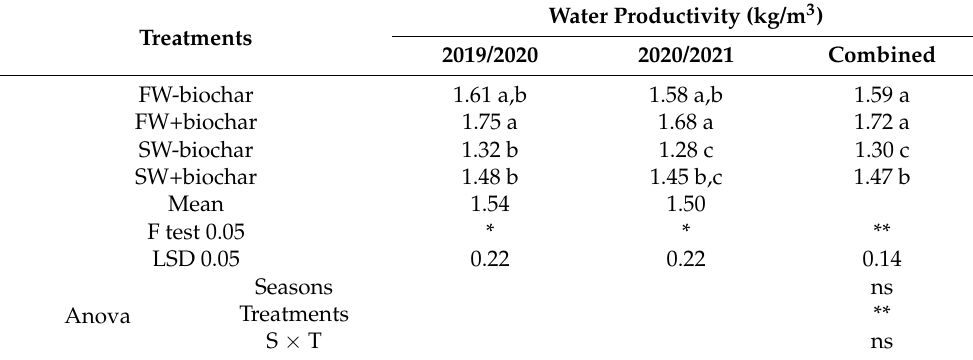
Table 6. Mean of water productivity (kg/m 3 ) as affected by water, biochar, and their combination treatments in both growing